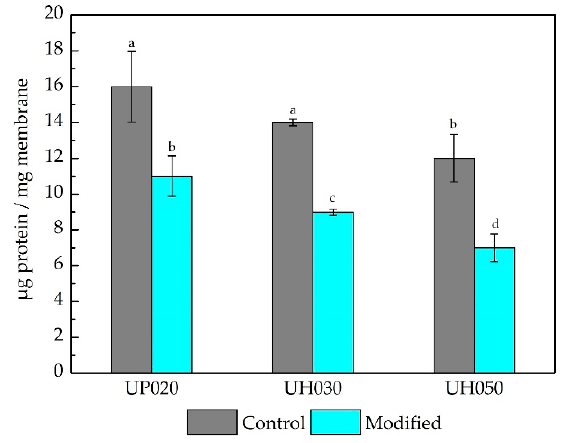
Figure 3. Bovine serum albumin (BSA) adsorption on the surface of control and modified membranes at a concentration of 0.5 g L − 1 for 6 h. Bars with different letters show a statistical difference ( p < 0.05).